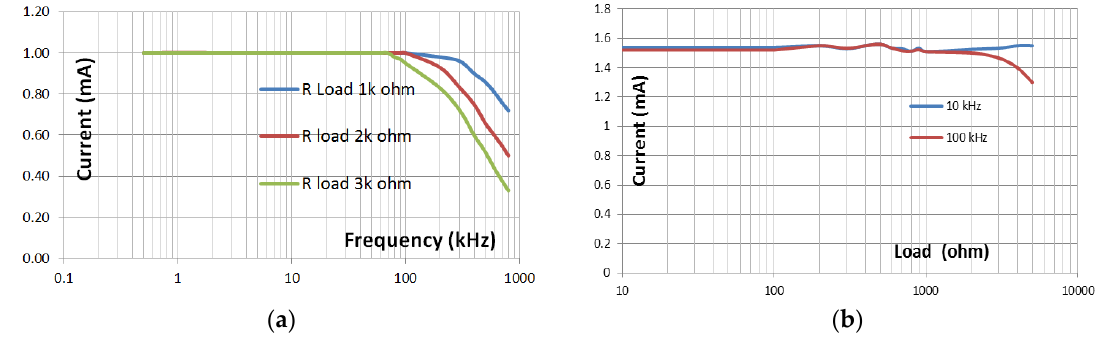
Figure 9. ( a ) The relationship between frequencies and loads in the Voltage Controlled Current Source (VCCS) to the currents; ( b ) the graphic of current stability to loads at 10 kHz and 100 kHz.